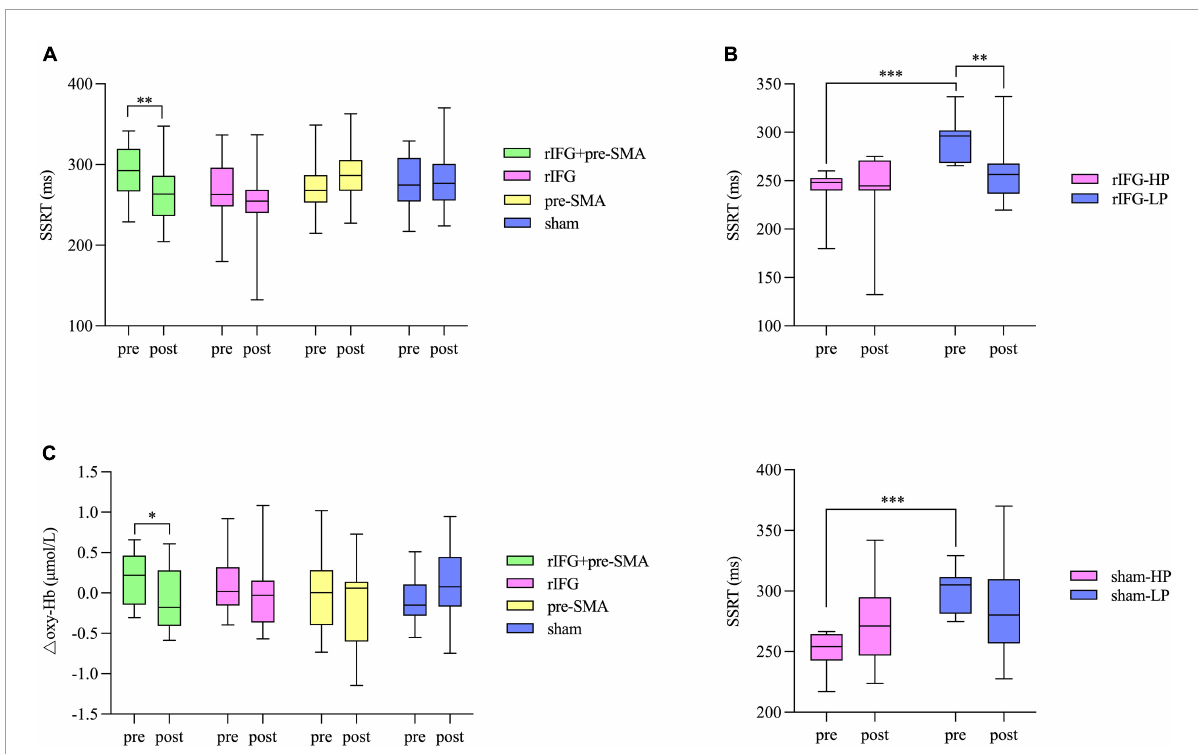
FIGURE5 Box and whisker plots, showing the effects of HD-tDCS on the outcome measures. (A) Behavioral performance in SST. (B) Significant interaction effects between subgroup and time for the rIFG condition (top) and sham condition (bottom) in the further analysis for SST. HP, high-performance subgroup; LP, low-performance subgroup. (C) Changes in (cid:77) oxy-Hb from pretest to posttest in the pre-SMA ROI. Boxes extend from the 25 to 75th percentiles with a horizontal line representing the median. Whiskers show the min to max values. ∗ p < 0.05, ∗∗ p < 0.01, and ∗∗∗ p <